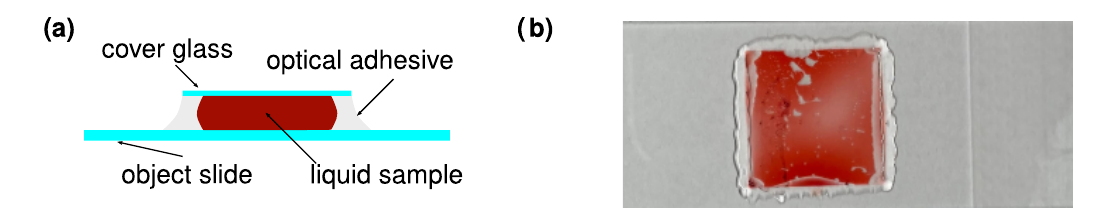
Figure A3. Experimental cells with diluted ink. Ink for verification is enclosed between the object and cover glass and sealed with optical adhesive, as shown in ( a ). A finished cell with red ink is shown in ( b